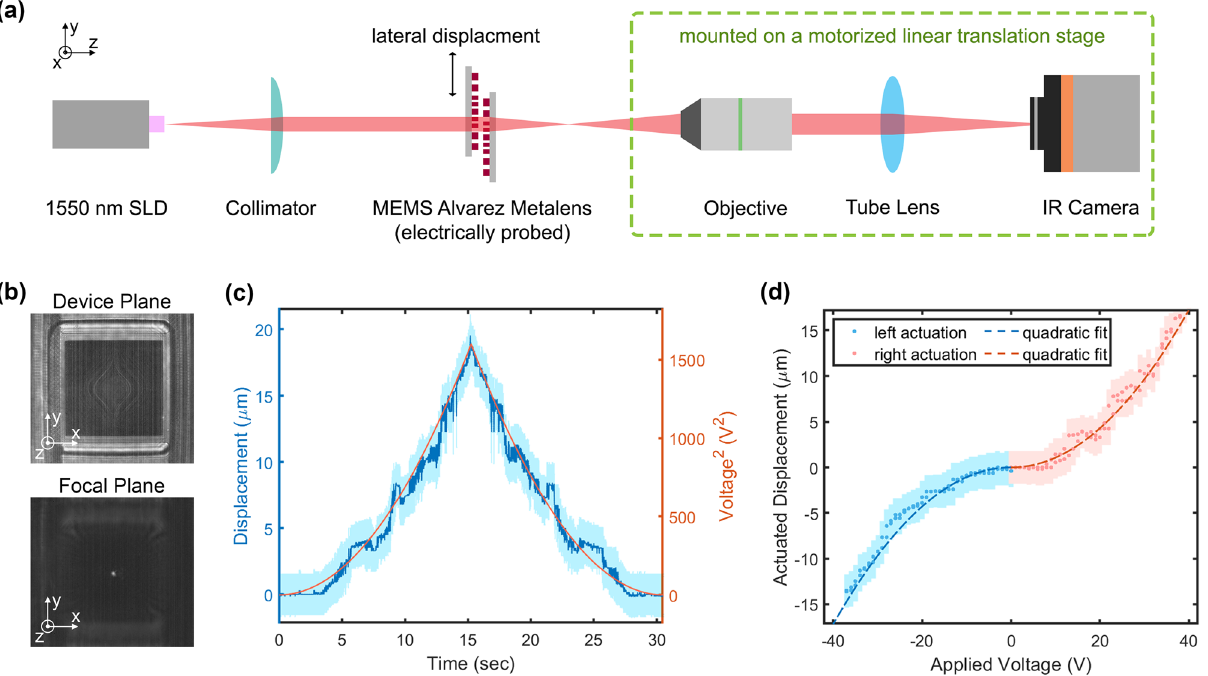
Figure 3. Experimental characterization of the Alvarez lens. ( a ) Experimental setup for electrostatic actuation and focal profile acquisition. ( b ) Exemplary device and focal planes of the Alvarez meta-optic lens actuated at 40 V towards the right. ( c ) Measured actuated displacement and actuating voltage of the MEMS platform follow the same trend closely, showing negligible hysteresis. ( d ) Actuated displacement for both directions follows the comb-drive quadratic characteristics closely. The light shade bands indicate the associated error